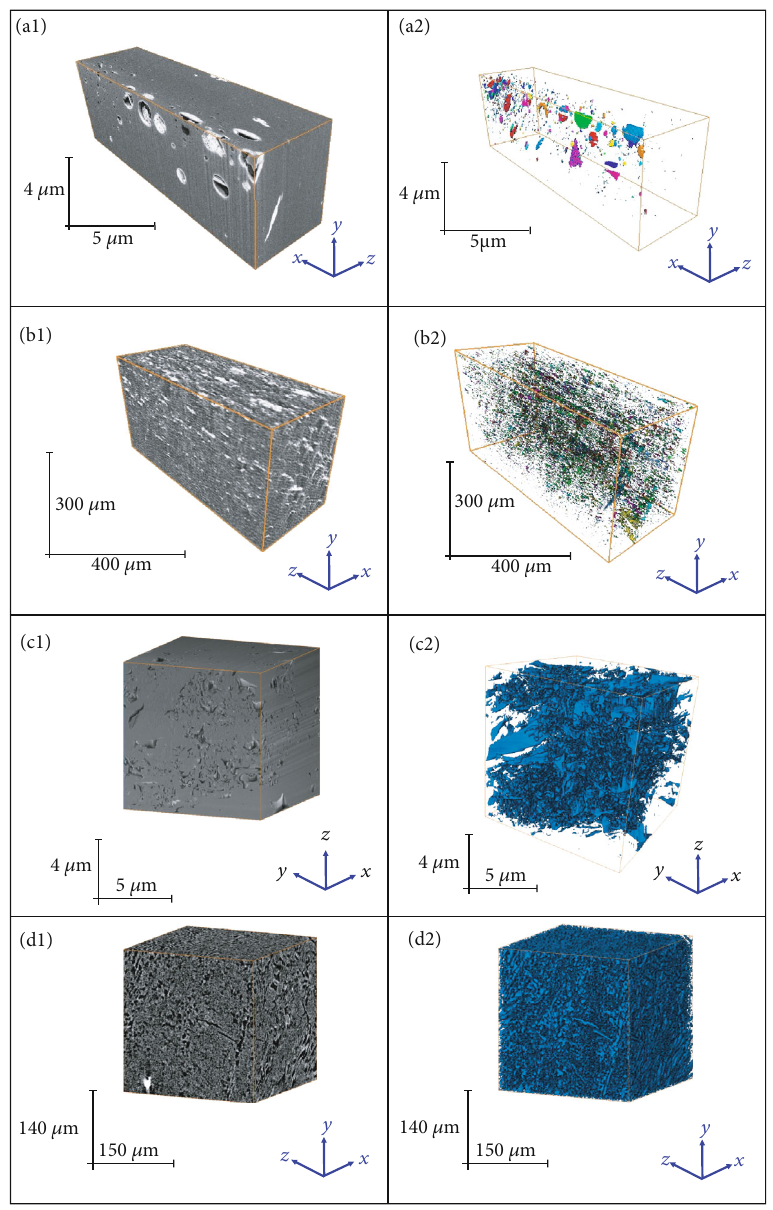
Figure 7: 3D reconstruction images and the extraction of pore-fracture networks: (a1, a2) FIB-SEM data of the BC sample; (b1, b2) X-ray μ -CT data of the BC sample; (c1, c2) FIB-SEM data of the LHG sample; (d1, d2) X-ray μ -CT data of the LHG sample (modi fi ed from Li et al. [51,